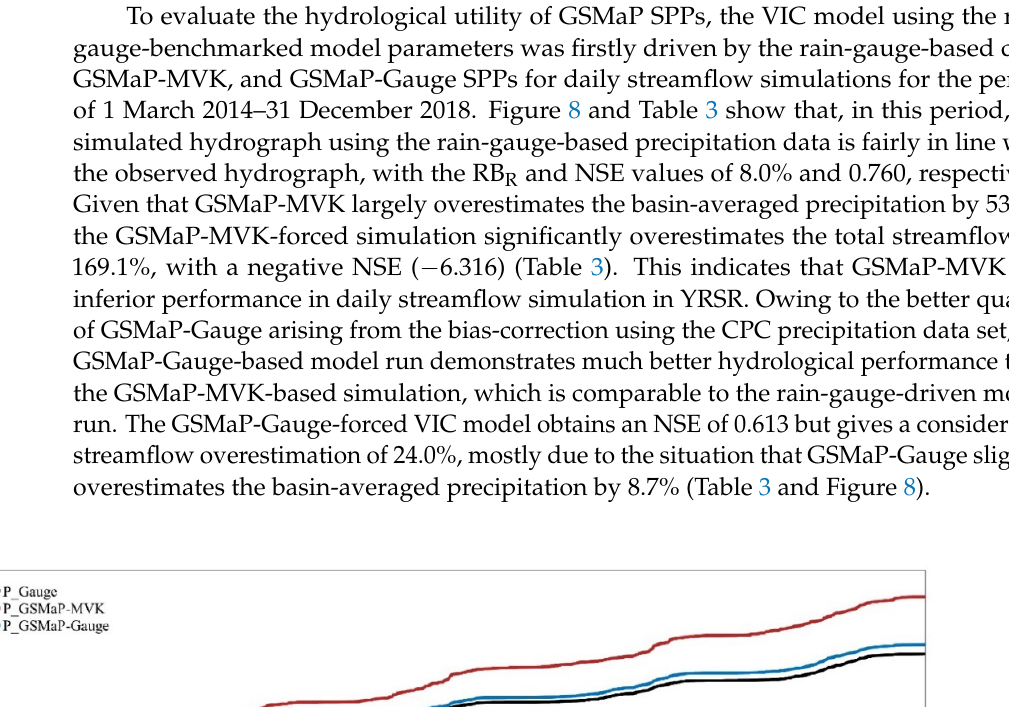
Table 3. Statistical indices of daily discharge simulations at the Tangnaihai hydrological station us- ing the rain-gauge-based precipitation data and the five GSMaP SPPs.